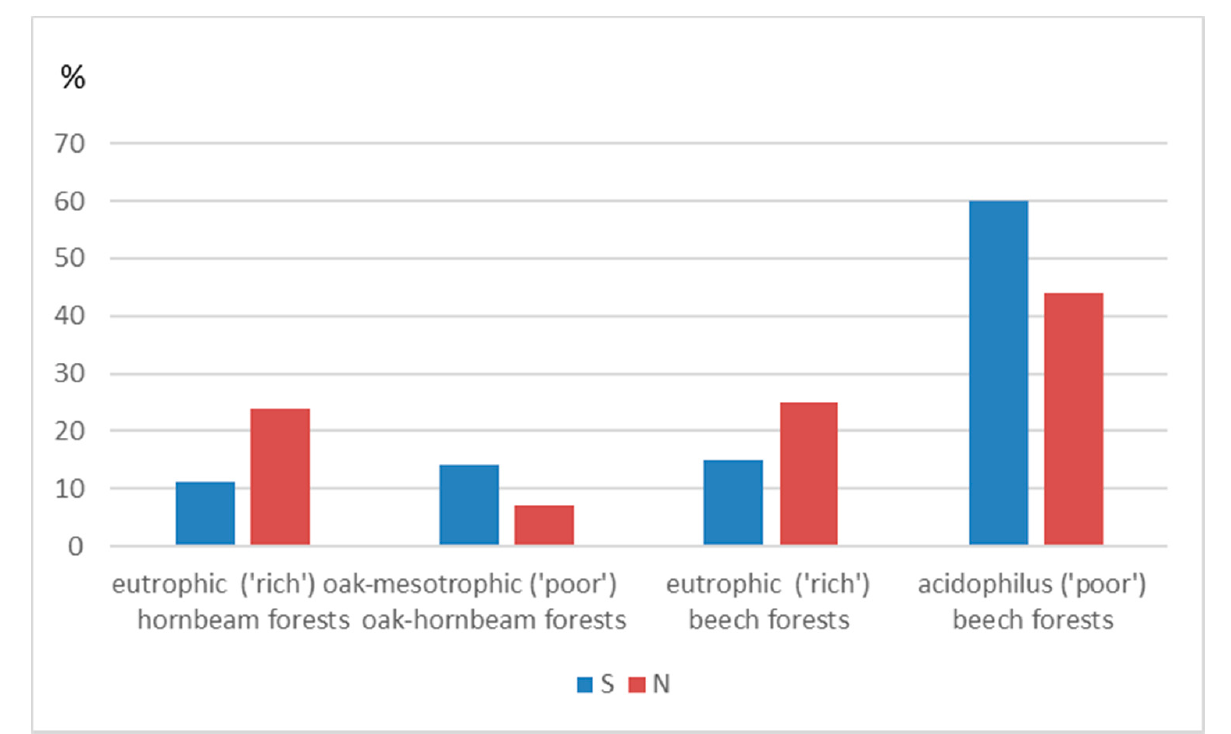
Figure 2. Comparison of the percentage distributions of the surface area (S) most important groups of potential natural vegetation (in the area covered by the study) and the percentage distributions of the total fir localities numbers